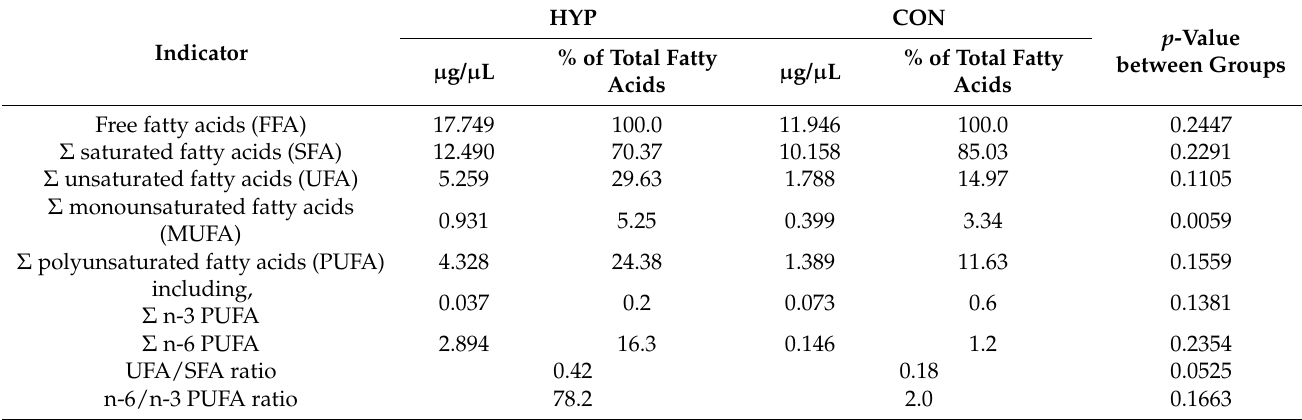
Table 3. Ratio of free fatty acids in blood serum of dairy cows under hyperthermia conditions (HYP) and in the control group